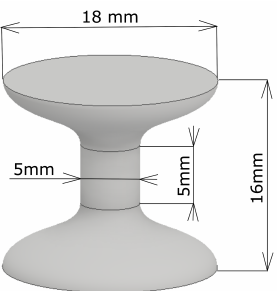
Figure 2. Dimensions of dog bone shaped specimen used for dynamic experiments.